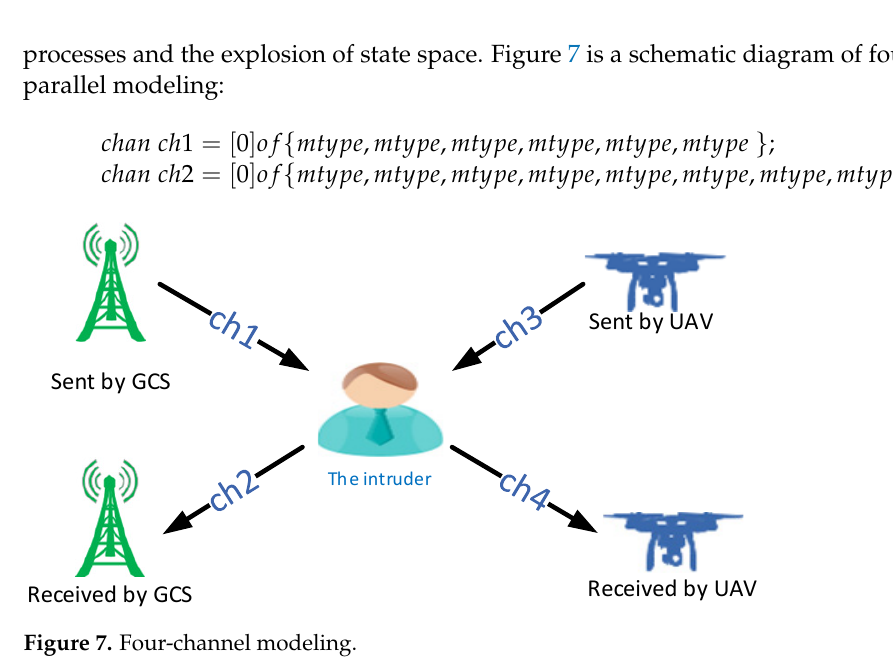
Figure 7. Four ‐ channel